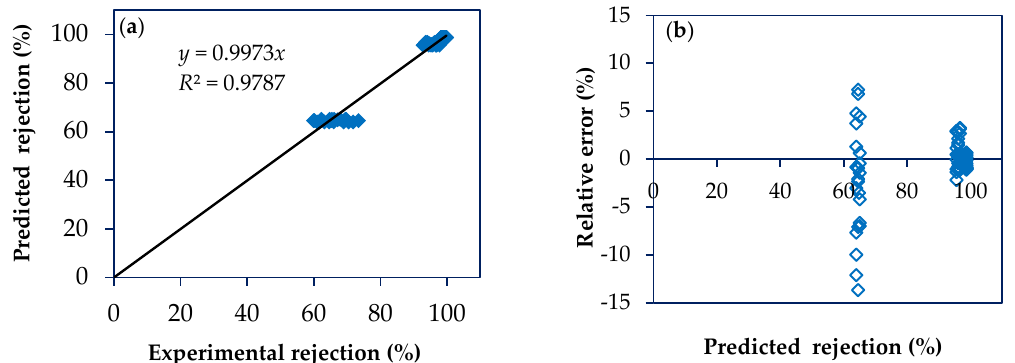
Figure 6. Scatter diagram for rejection data external to the model. ( a ) Plot of predicted rejections vs. experimental rejections; ( b ) Plot of relative error as a function of predicted rejection.